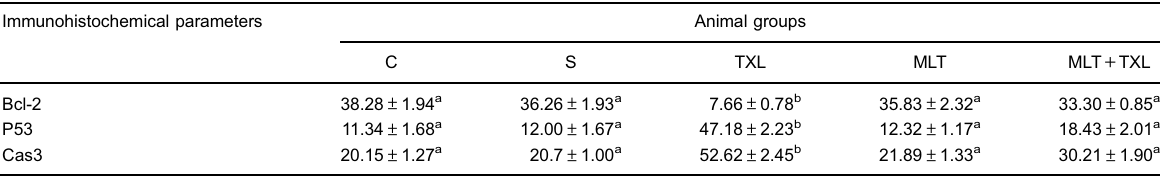
Figure 2. Photomicrographs of testicular tissues of control and experimental animal groups stained for Bcl-2 immunoreactivity. A and B , control group; C and D , sham group; E and F , taxol (TXL)-treated group; G and H , melatonin (MLT)-treated group; I and J , MLT + TXL- treated group. There was no staining on the negative control sample ( K ). SC: Sertoli cells; SG: spermatogonia; PS: primary spermatocytes; RS: rounded spermatids; ES: elongated spermatids; LC: Leydig cells; IT: interstitium. Scale bar: 0.05 mm. Table 3. Percentage of cells immunostained for Bcl-2, P53, and Cas3 reactive proteins in testicular tissues of control and experimental animal